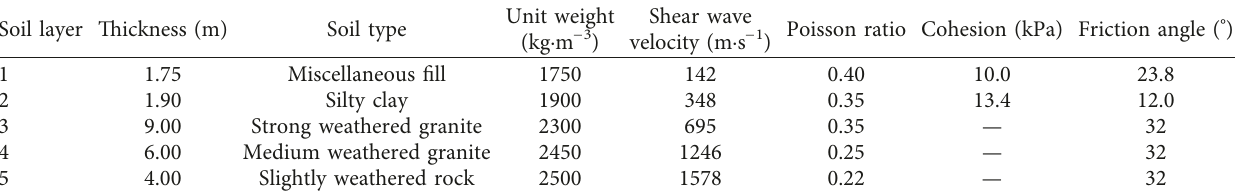
Figure 6: Soil-underground structure interaction analysis model. Table 2: Soil physical properties for site I.